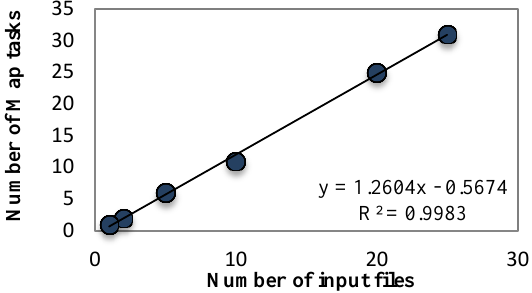
Figure 7. Number of input files versus number of generated Map tasks by Hadoop.